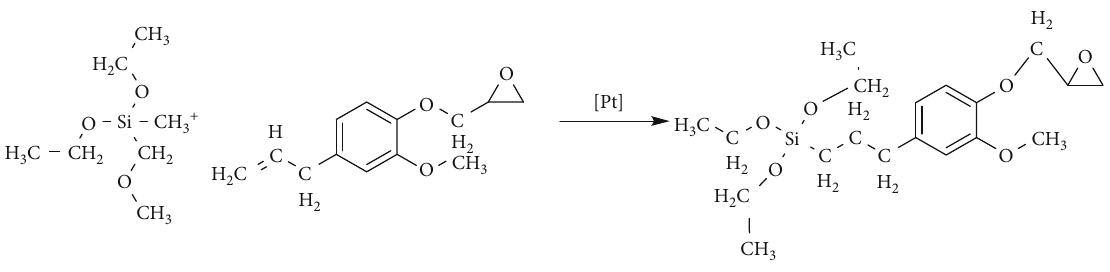
Figure 6: Synthesis mechanism of SiO